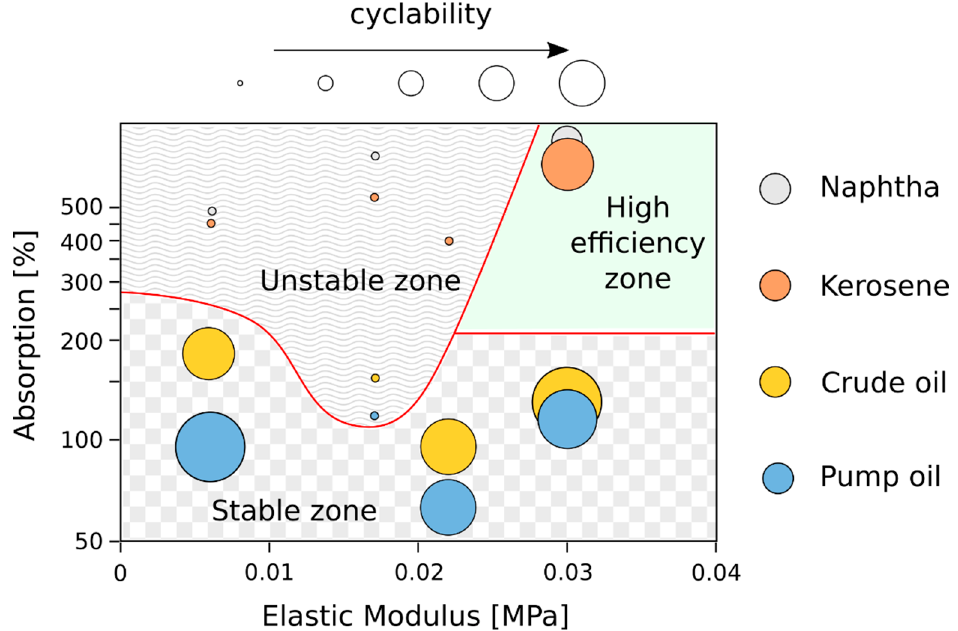
Figure 12. Correlation between the absorption capacity (%), elastic modulus (MPa), and